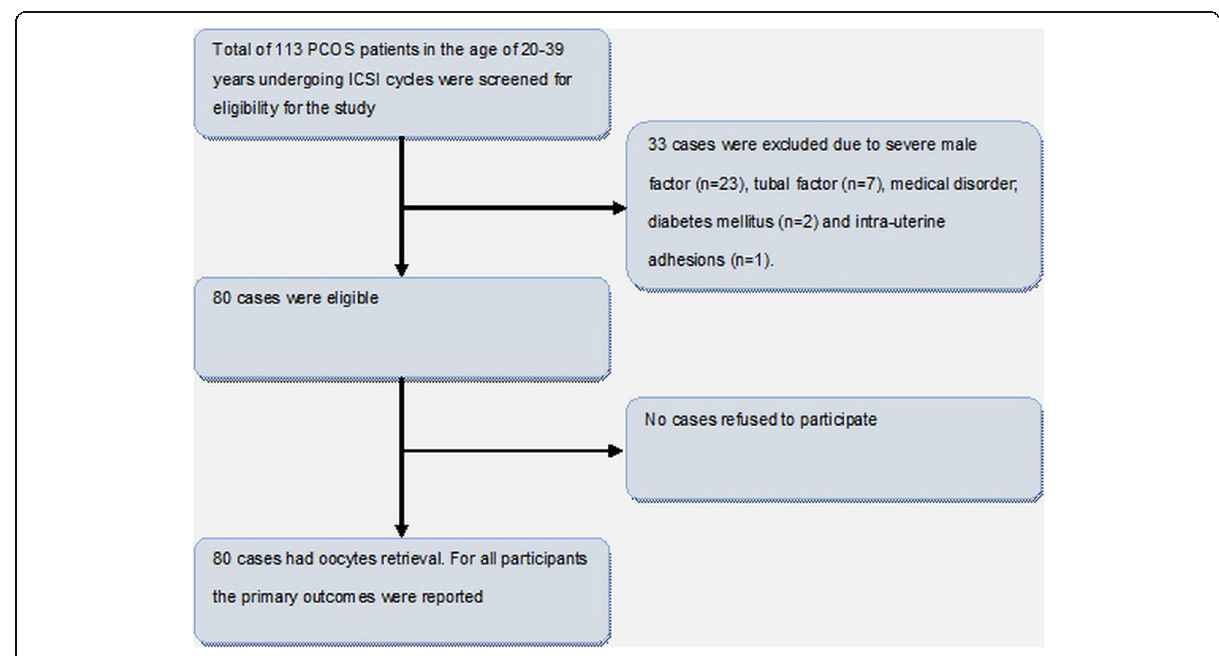
Fig. 1 Flow chart of the study population